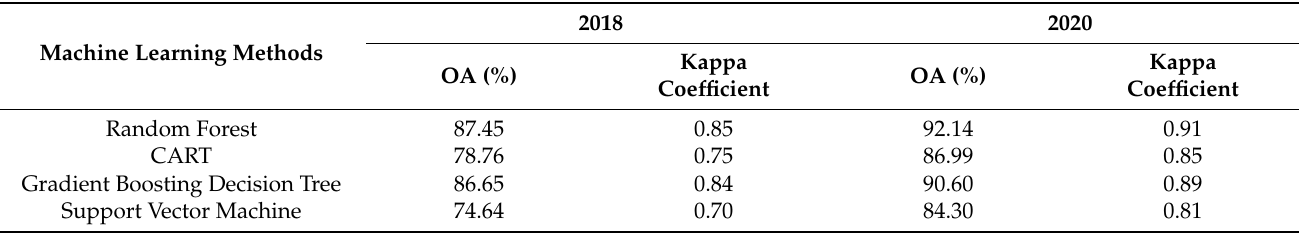
Table 6. Comparison of the accuracy of several machine learning